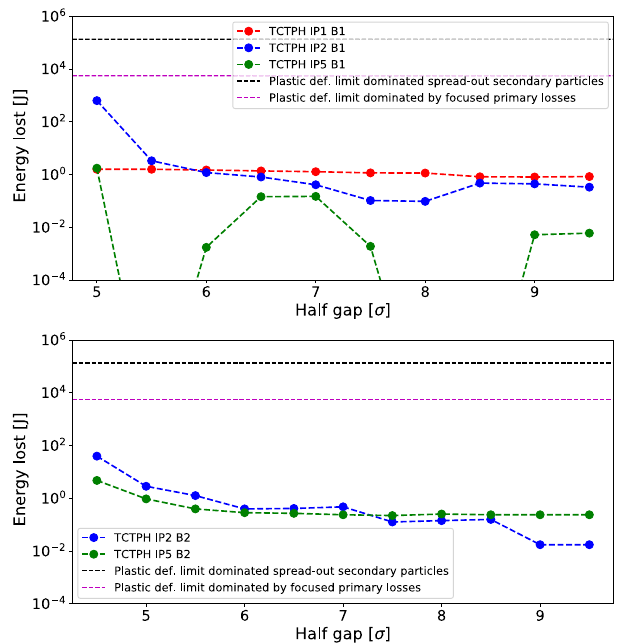
FIG. 13. Losses at the TCTs at the higher luminosity experi- ments from simulation results of a SMPF mode scenario as a function of the TCTs half aperture for B1 (top) and B2 (bottom). Note that the discontinuity observed on the top plot green line is due to statistic limitations and indicates nearly no losses at this collimator. The energy lost by one primary 208 Pb 82 þ ion of 6.37 Z TeV in the simulations after the applied normalization and scaling as explained in the text, corresponds to 1 . 5 × 10 − 1 J in this plot. For B2 no losses are observed in the TCT in